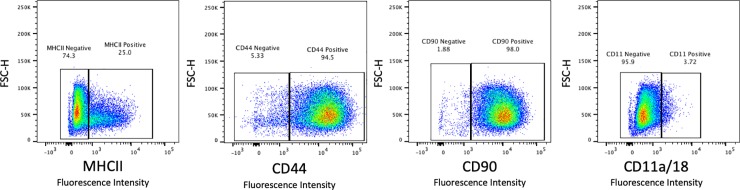
Positive and negative cell populations for each antibody illustrate marker expression in MSCs.A representative MSC sample from passage 2 shows MHC class II, CD44, CD90 and CD11a/18 expression.